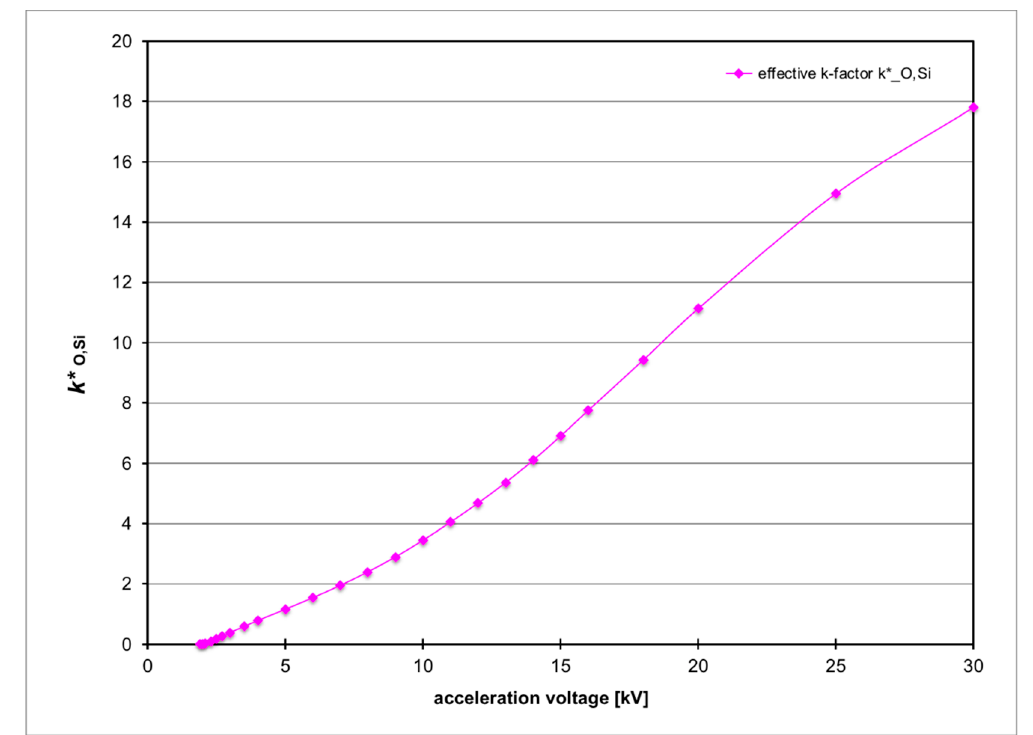
Figure 4. MC simulation of predicted k * O,Si k-factor vs acceleration voltage for SEM-EDXS with standard Si detector (atmospheric thin film polymer window, take-off angle of 22°).